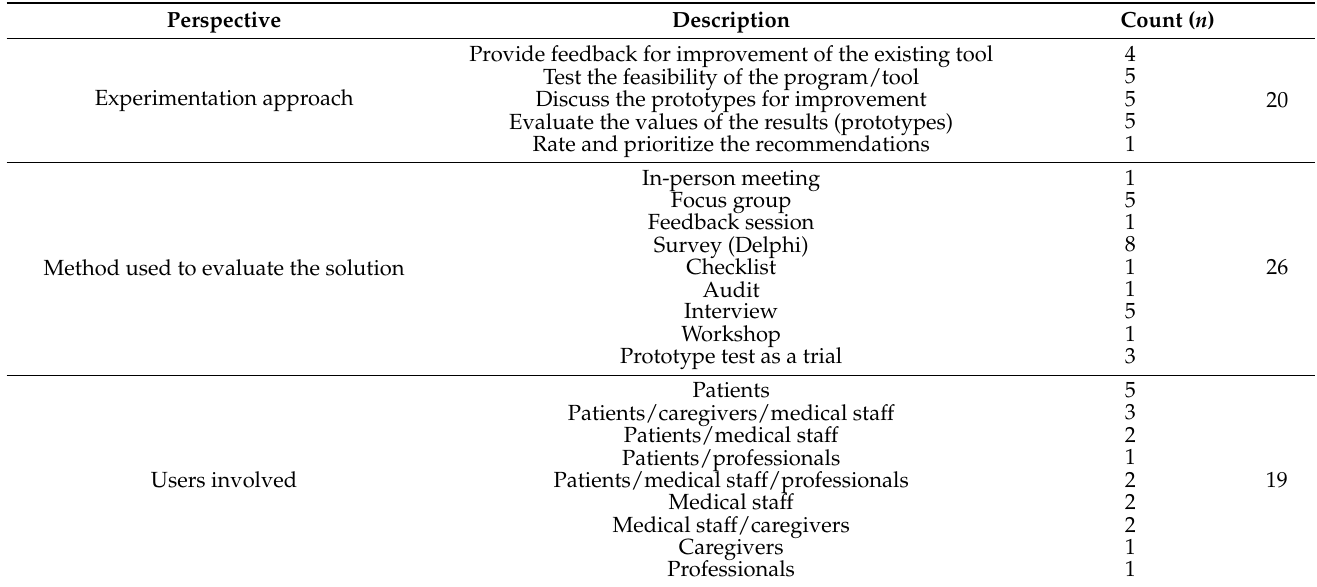
Table 9. Summary of the study’s